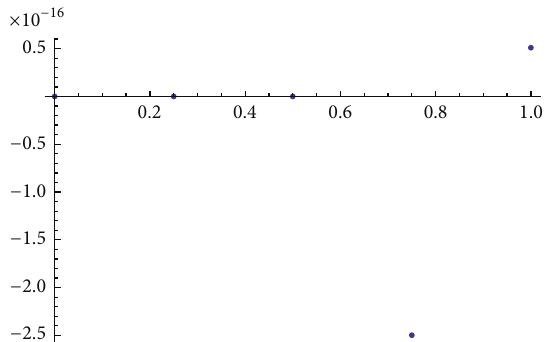
Figure 2: Plot of the absolute error with ℎ = 0.25 , 𝑡 ∈ [0,1] , 𝛽 = 1 , 𝜏 = 1 .